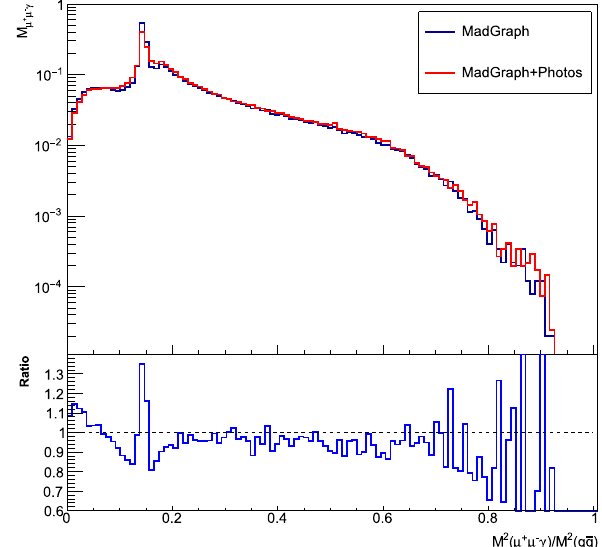
√ s = 240 GeV Fig. 6 The distribution of μ + μ − γ invariant mass for with all possible μ + μ − pairs contributing (for each event four entries/- combinations are added in the histogram). The upper panel shows the absolute distributions from the two generators, the lower panel shows the ratio of the two. The agreement is much better than what could have been deduced from Appendix B.3, where technical bias due to identical particles partial ordering was present. Note events migration from the Z peak to side bands. This is due to approximations in Photos kernel, for details see the